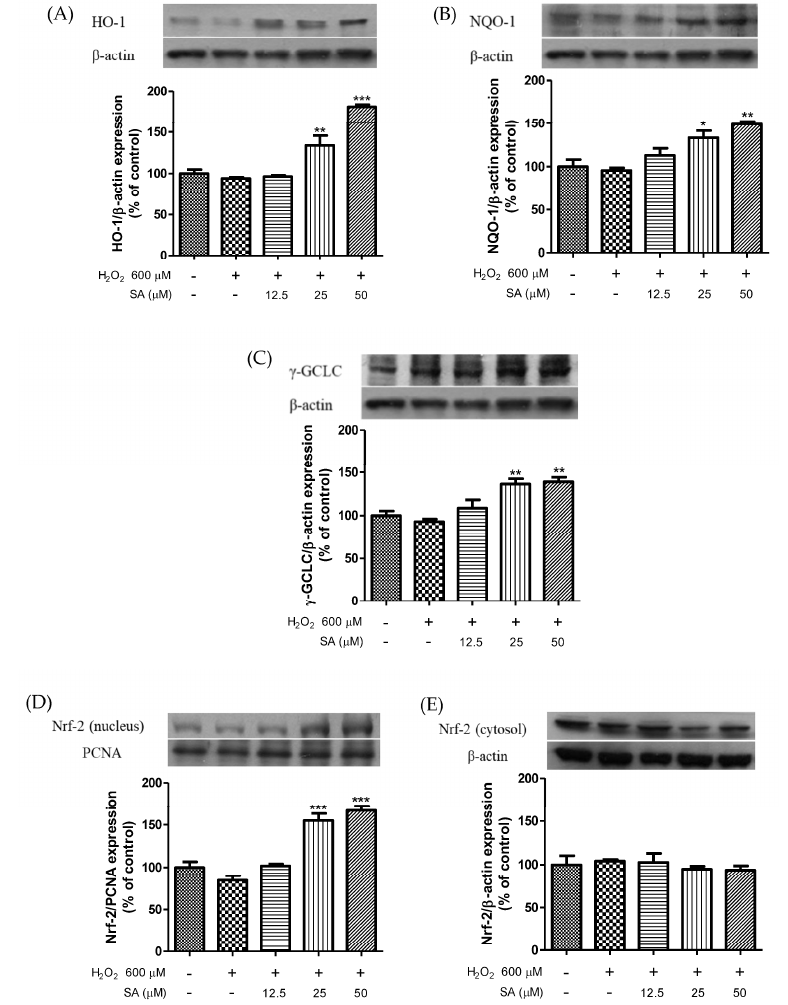
Figure 4. Effect of sinapic acids on HO-1 ( A ), NQO-1 ( B ), and GCLC ( C ) protein expression and Nrf-2 expression levels in nucleus ( D ) and cytosol ( E ) against hydrogen peroxide (600 μ M) in EA.hy 926 cells. Each value was expressed as the mean ± standard error ( n = 3). Statistical significance was analyzed using the Tukey test. * p < 0.05, ** p < 0.01, and *** p < 0.001 versus hydrogen-peroxide-treated cells. NO is essential for maintaining vascular function in the endothelium. Phosphoryla- tion of eNOS can regulate NO production [31] and is essential for the improvement of CVD [32]. Akt mediates NO production via phosphorylation of eNOS, which promotes endothelial cell migration and angiogenesis [33]. A previous study reported that eNOS